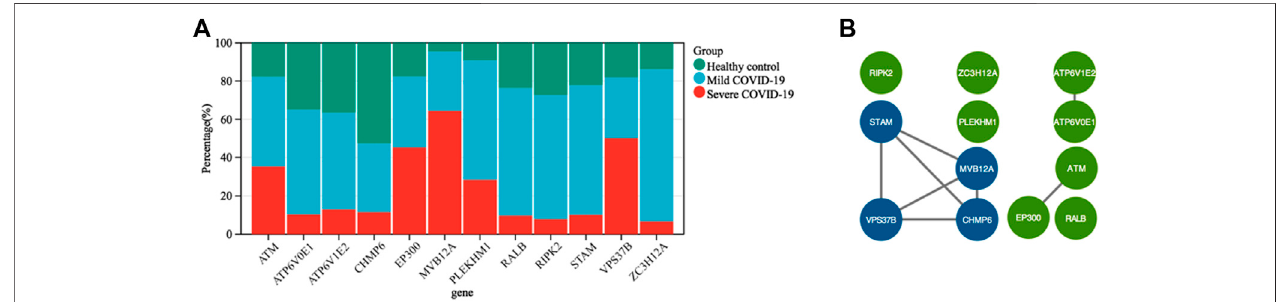
FIGURE 4 | (A) Stacked bar chart shows the expression value percentage of the 12 genes involved in the autophagy process in patients with severe COVID-19, mild COVID-19, and healthy controls. (B) Protein – protein interaction network was created using STRING and visualized in Cytoscape. The core cluster analyzed by MCODE is indicated with blue